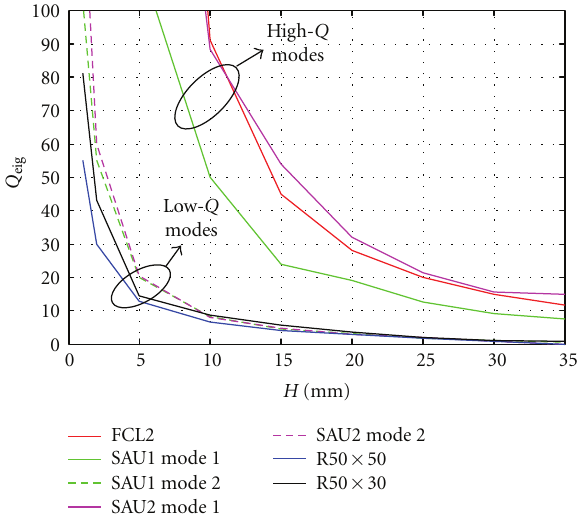
Figure 17: Radiation Q s for di ff erent antennas/modes.